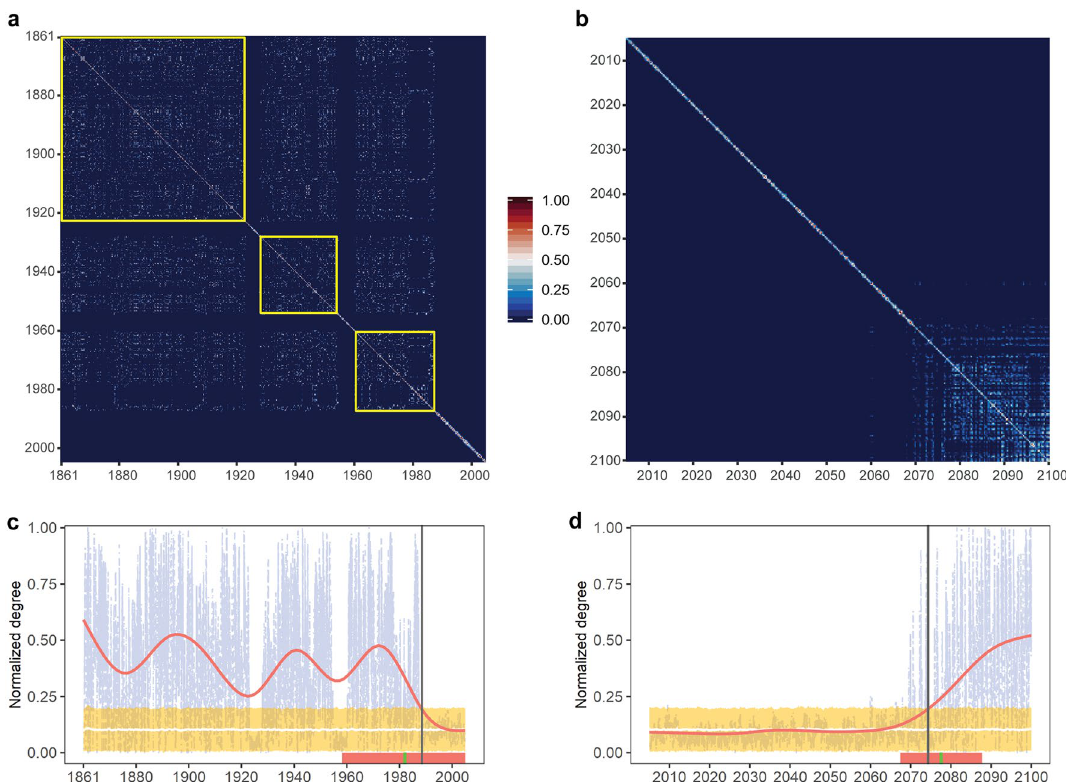
Figure 4. Temporal transitions of global MHW dynamics. Panels show temporal connectivity matrices (TCMs) originating from ( a ) historical and ( b ) RCP 8.5 networks. A TCM shows the similarity of each timeframe with all other timeframes. Yellow frames in ( a ) highlight the timescales of recurrent MHWs. Temporal transitions are captured by the normalized node degree of the TCMs for ( c ) historical and ( d ) RCP 8.5 scenarios. Red lines in ( c , d ) are Generalized Additive Model (GAM) fits to node degree data; yellow bands are 95% confidence intervals of random phase null models ( n = 1000, with average trend in white); vertical gray lines show years of transition determined from the intersection of GAM fits with the upper confidence limit of null models; vertical green lines and orange bands show the median transition year estimated from individual Earth System Models ( n = 12, Supplementary Fig. 3) and the bootstrap error for the median,